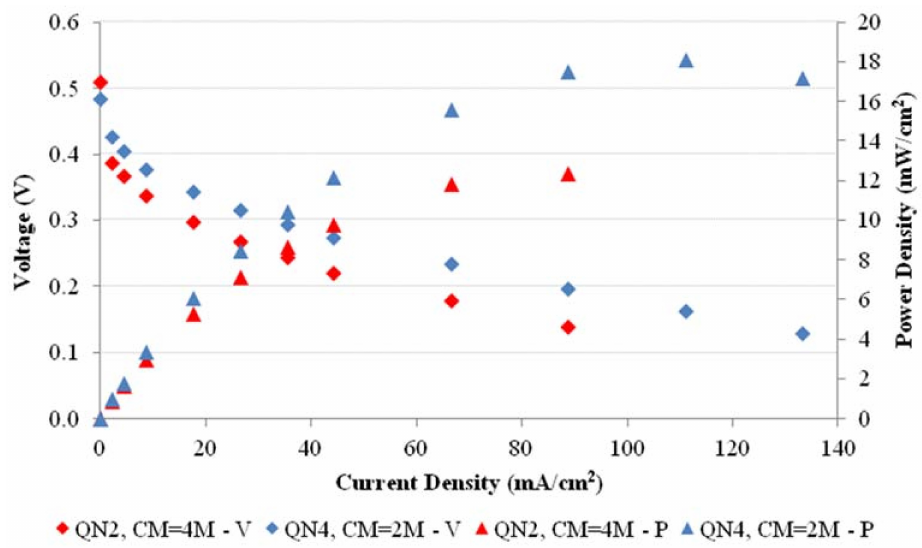
Figure 5. Voltage and power polarization curves comparison for MEAs QN2 and QN4 for the best methanol concentration (CM). Operating conditions: temperature, 25 ◦ C; pressure, 1 atm; methanol/air flow rates, 0.11/130 mL/min.